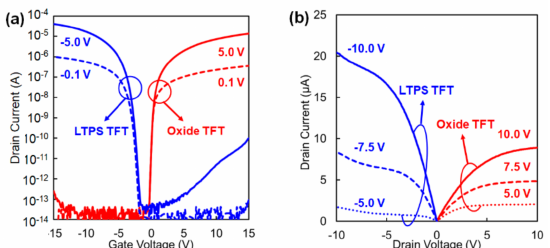
Figure 7. Measurement results of an n-type oxide TFT (red) and a p-type LTPS -TFT (blue). ( a ) Transfer characteristics. ( b ) Output characteristics.